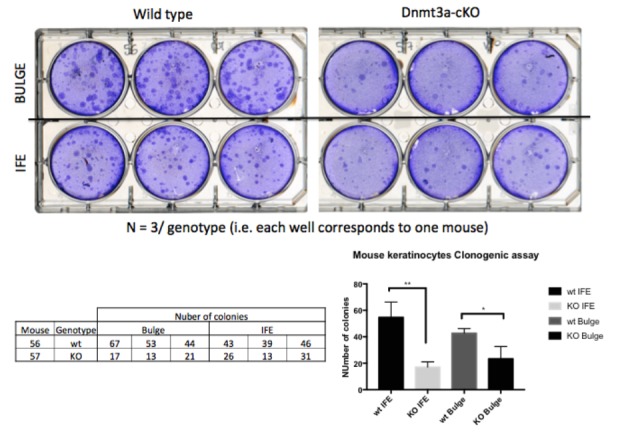
DOI:
http://dx.doi.org/10.7554/eLife.21697.040